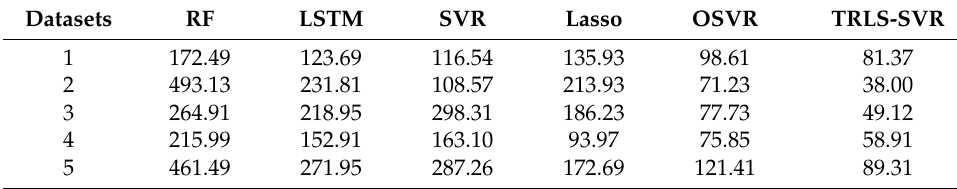
Table 3. MAE of different methods in five